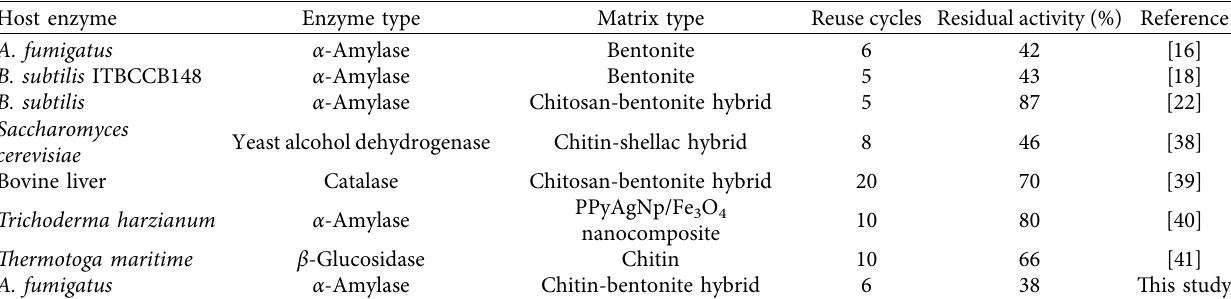
Table 3: The ratio of reuse and number of cycles for α -amylase in other